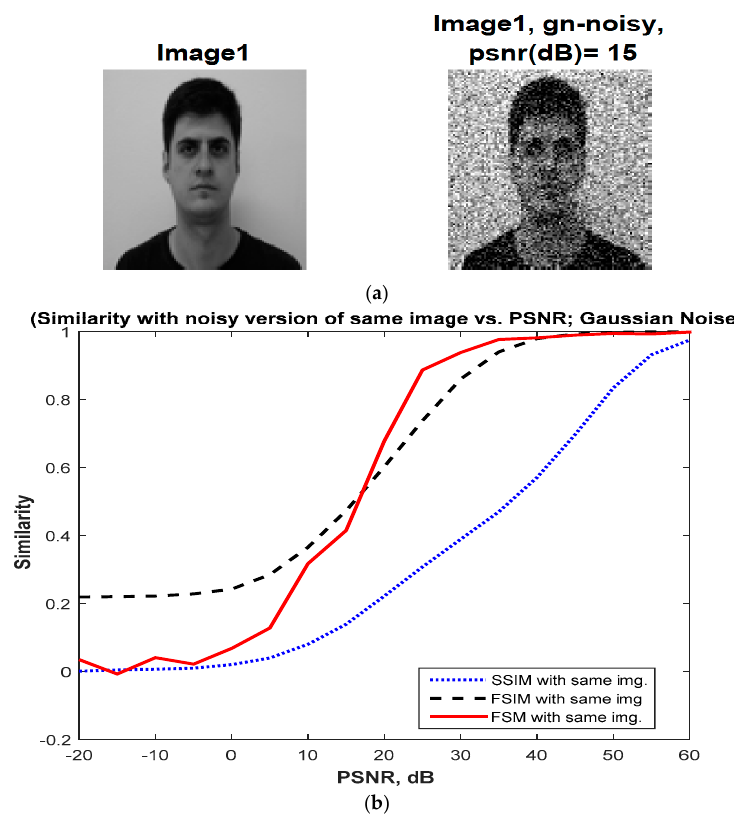
Figure 17. Performance of similarity measures using similar images under Gaussian noise; ( a ) Above: The test images; ( b ) Performance comparison among (SSIM, FSM and FSIM) under Gaussian noise. Appl. Sci. 2017 , 7 , 786